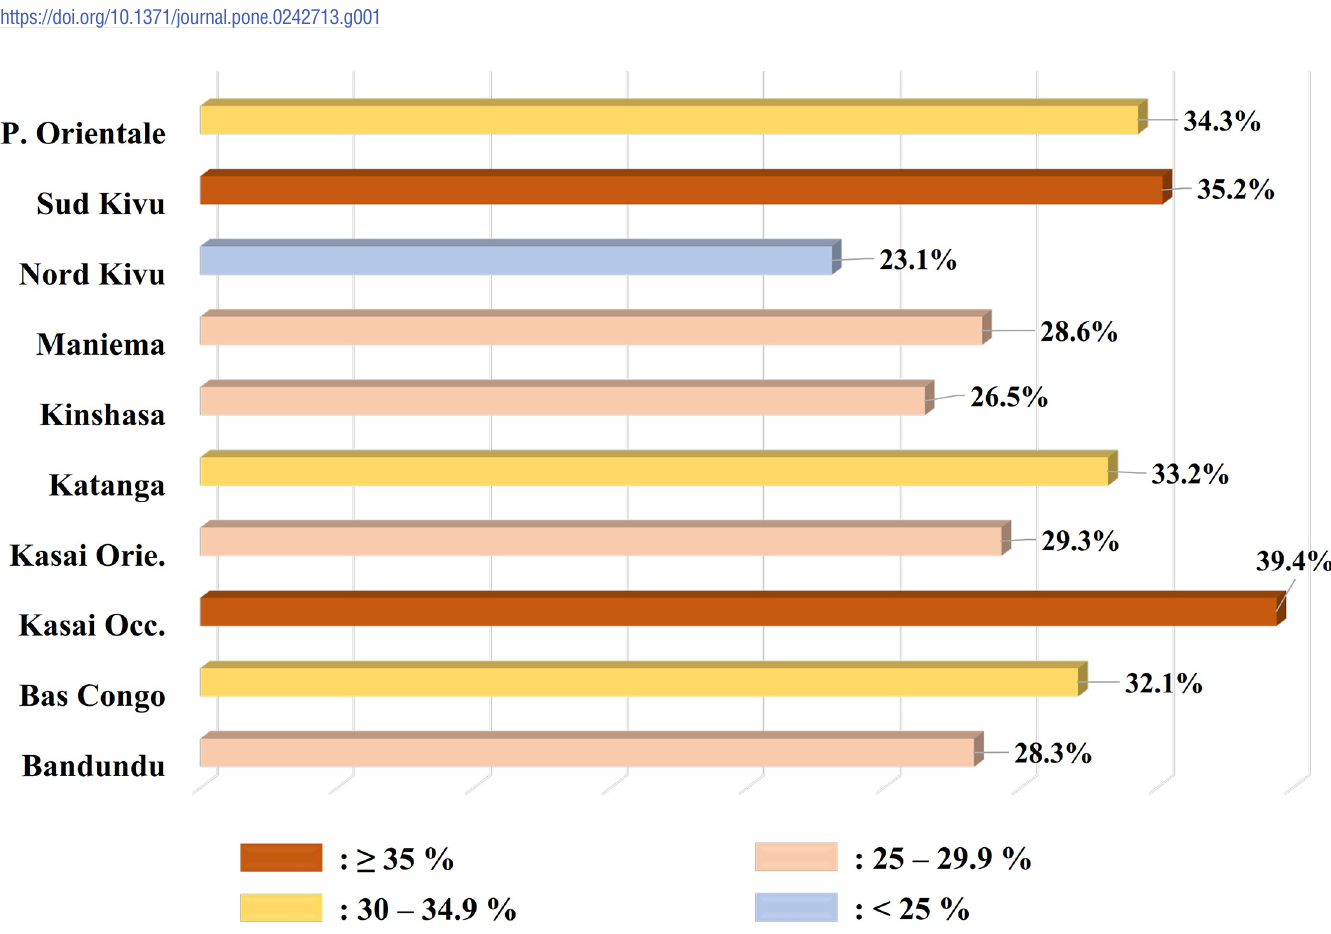
Fig 2. Prevalence of Plasmodium ssp infection by province using PCR analysis.